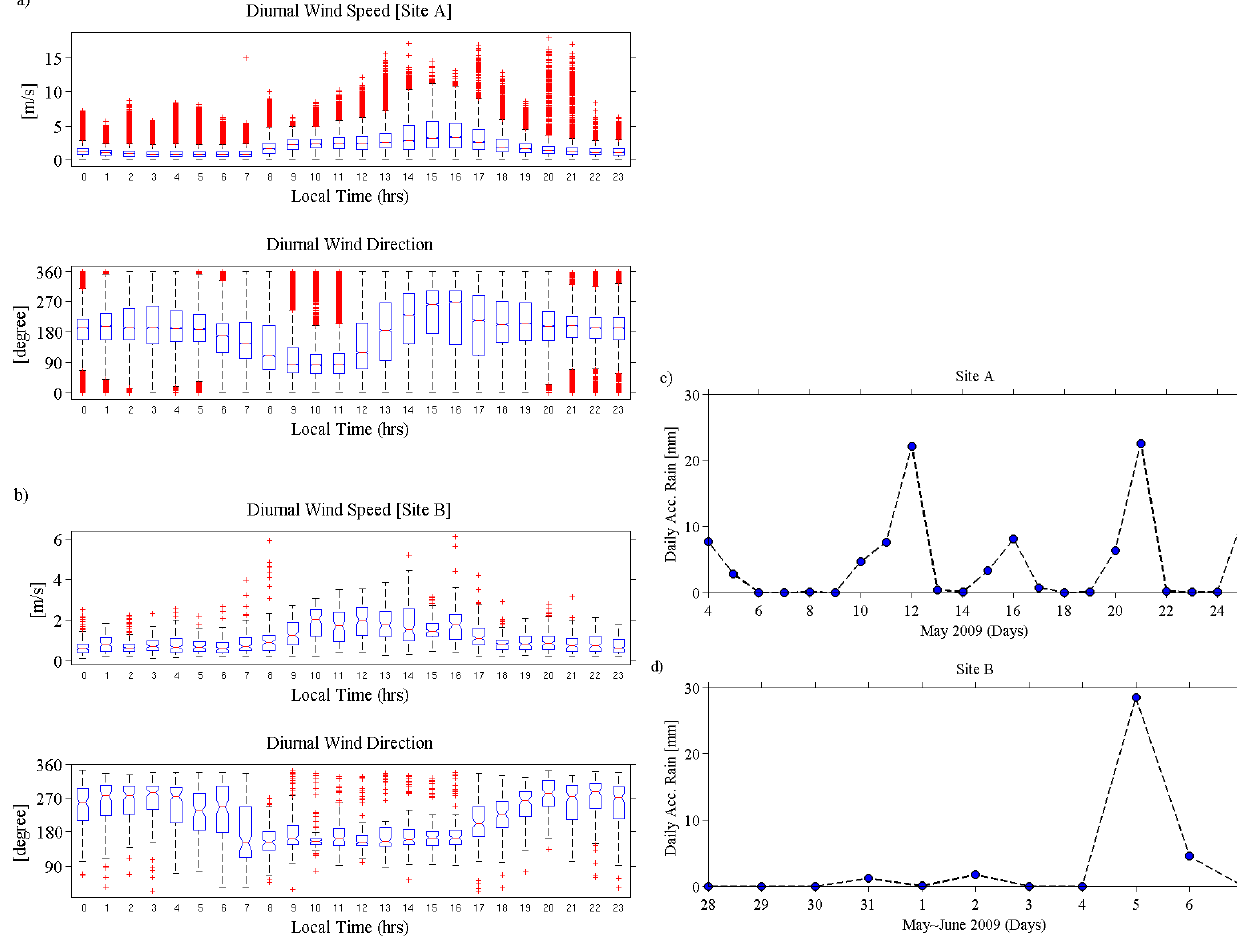
Figure 2: Local Meteorological Variables measured during sampling: a) and b) Diurnal wind speed and wind direction at Site A and Site B, respectively. The red-dots are the outliers which have a value more than 1.5 times the interquartile range away from the top and bottom of the box, c) and d) Daily accumulated precipitation at Site A and Site B, respectively.